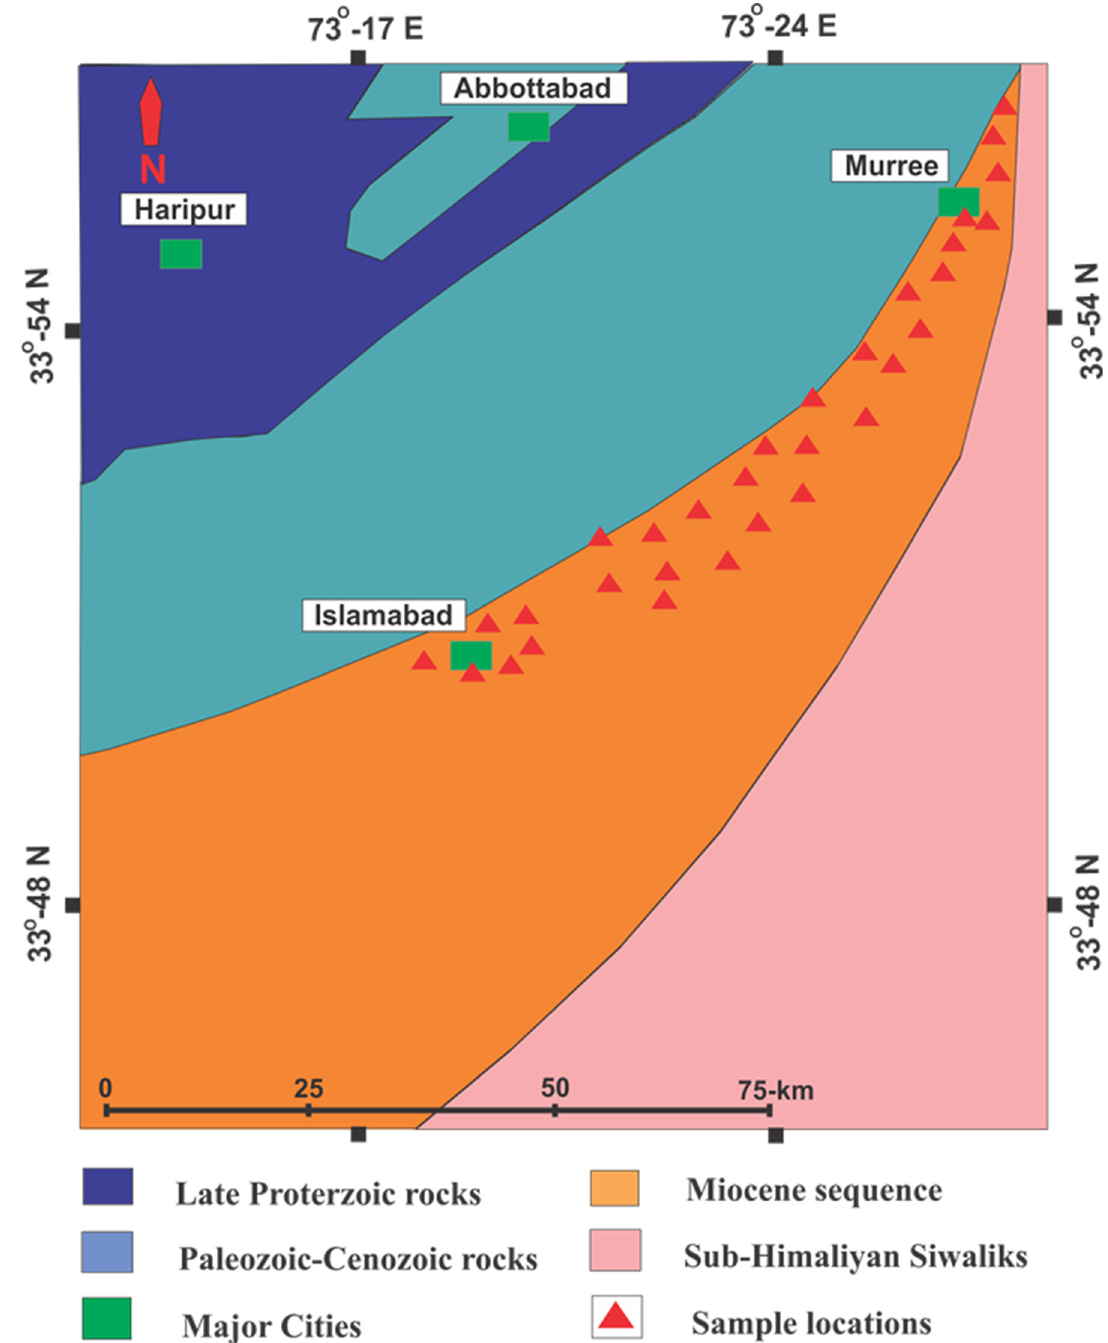
Figure 2. Map of the study area showing the sample localities